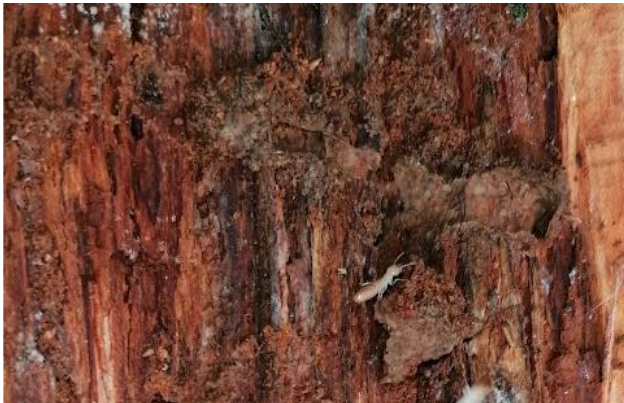
Figure 3. The arthropods inhabiting deadwood contribute to its